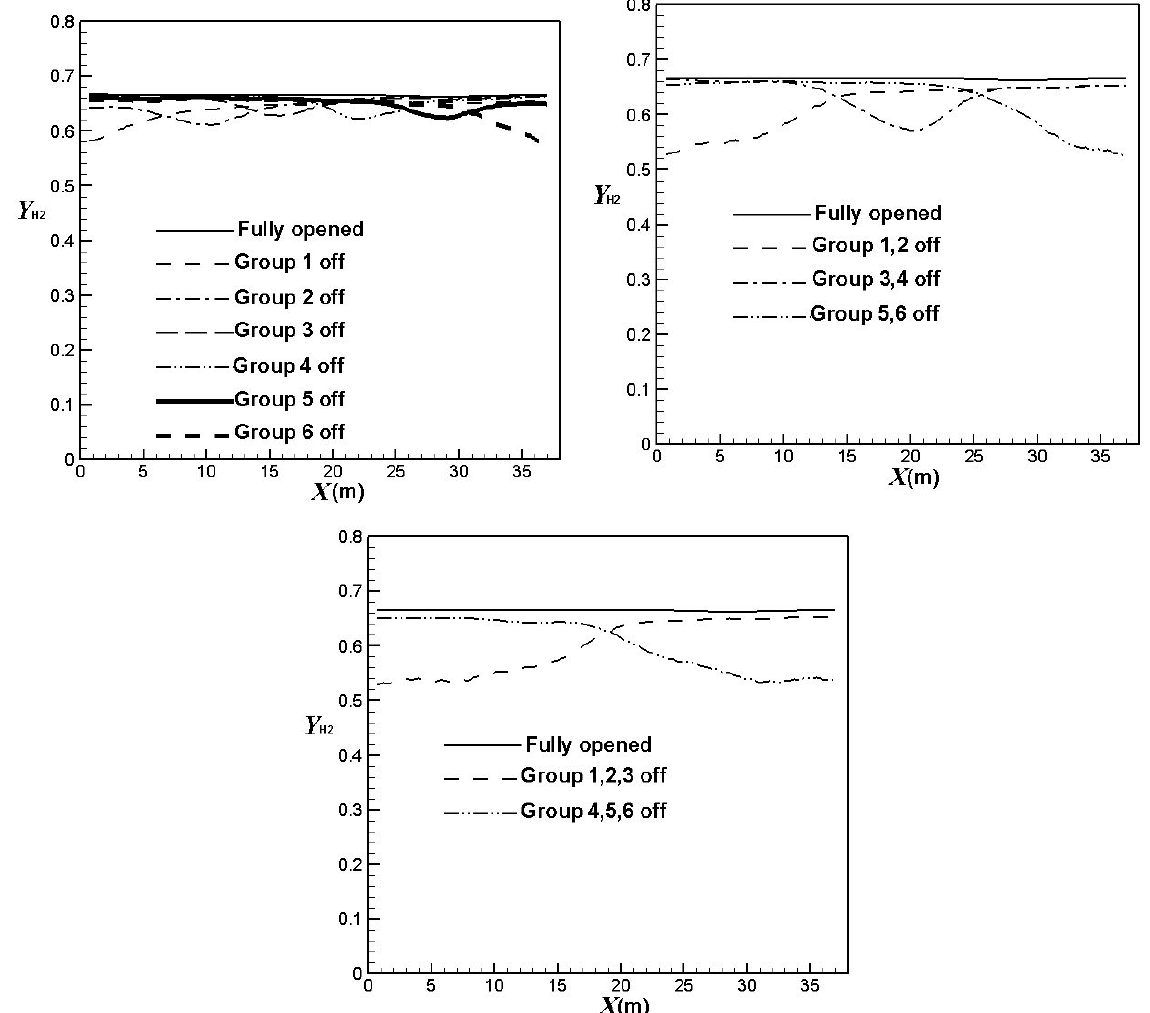
Figure 8. Comparison of average hydrogen yields using different burners on/off combinations. Table 2. Average hydrogen yields using different burners on/off combinations.